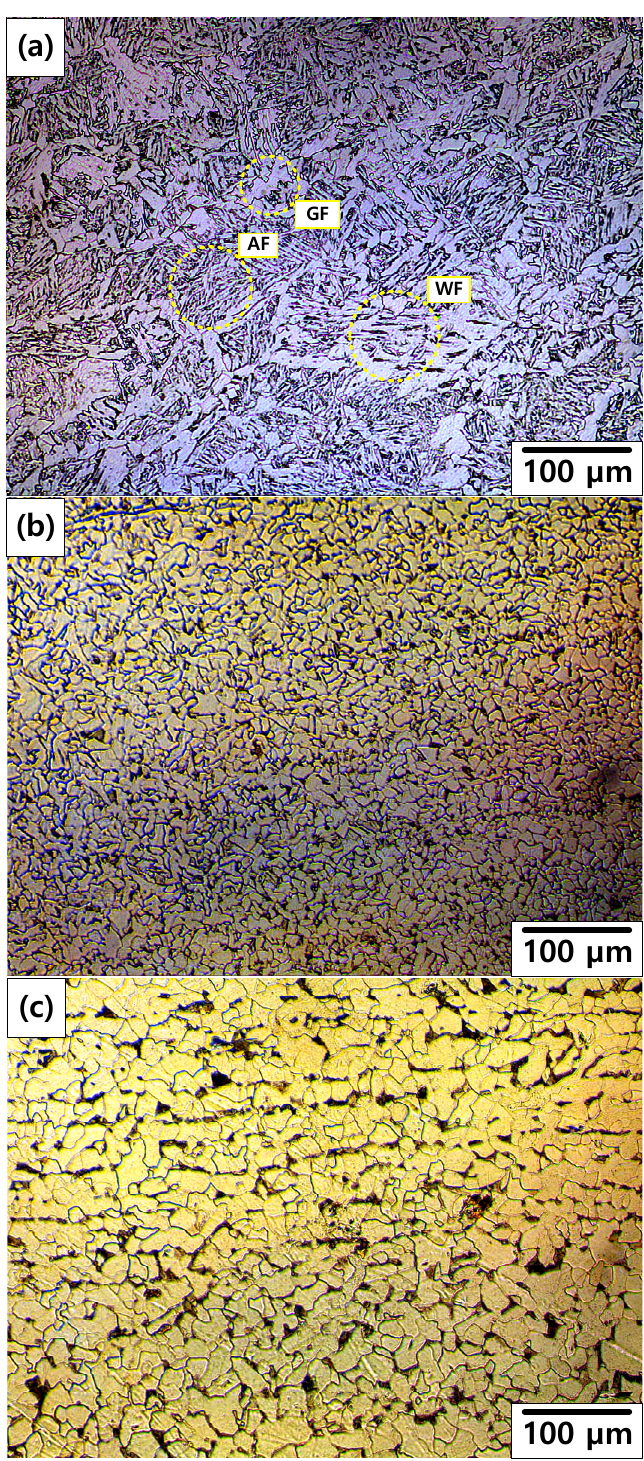
Figure 12. OM of welded carbon steel specimens from the weld zone to base metal: ( a ) Weld zone, ( b ) heat affected zone, and ( c ) base metal.